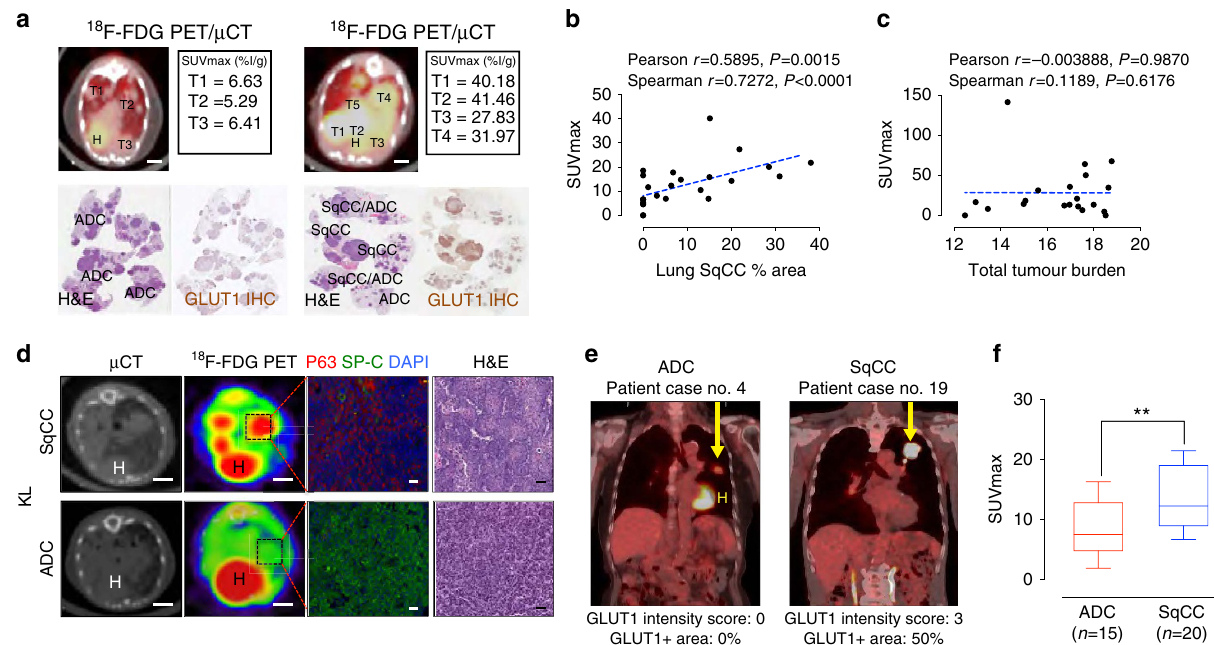
Figure 6 | Increased 18 F-FDG uptake in lung SqCC. ( a ) Representative 18 F-FDG-PET/ m CT overlays comparing KL animals with only ADC tumours (left) and animals possessing SqCC tumours (right). H, heart. Scale Bar, 4mm. ( b , c ) Correlative analysis between SUVmax and % area of SqCC tumours ( b ) and total tumour burden ( c ). Pearson and Spearman R -values and probabilities are presented for correlations. ( d ) 18 F-FDG uptake in the areas of SqCC and ADC within the same KL tumour-bearing mouse. Scale bar, 3mm. Histological phenotype (SqCC or ADC) was determined by IHC analysis of p63 (SqCC) and SP-C (ADC). Scale bar, 50 m m. H, Heart. ( e ) 18 F-FDG uptake of representative human ADC (case 4, Supplementary Table 1) and SqCC (case 19, Supplementary Table 1) patients. H, heart. ( f ) Comparison of SUVmax between ADC and SqCC patients. Each box represents the lower quartile, median and upper quartile, and whiskers represent the 10th and 90th percentiles of the data. Two-tailed t -test. ** P o